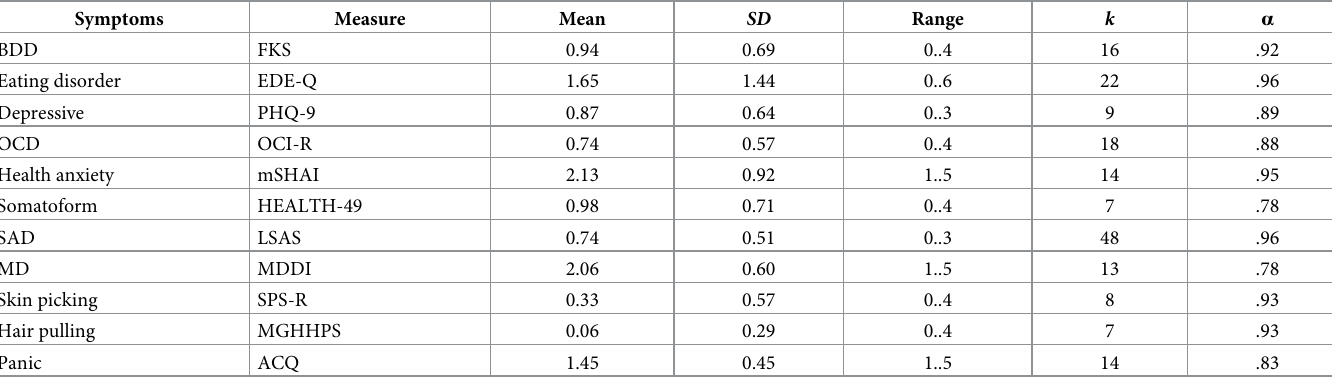
Table 1. Univariate statistics and reliability of symptom